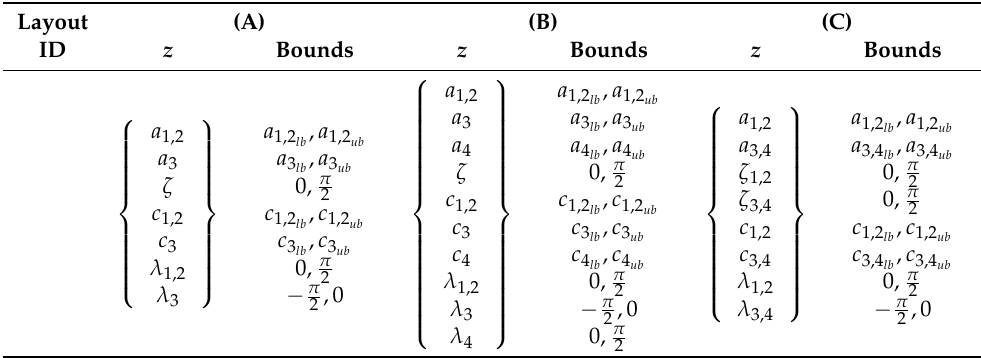
Table 1. Sets of optimization parameters z and corresponding bounds according to geometrical definitions, for the three considered thruster